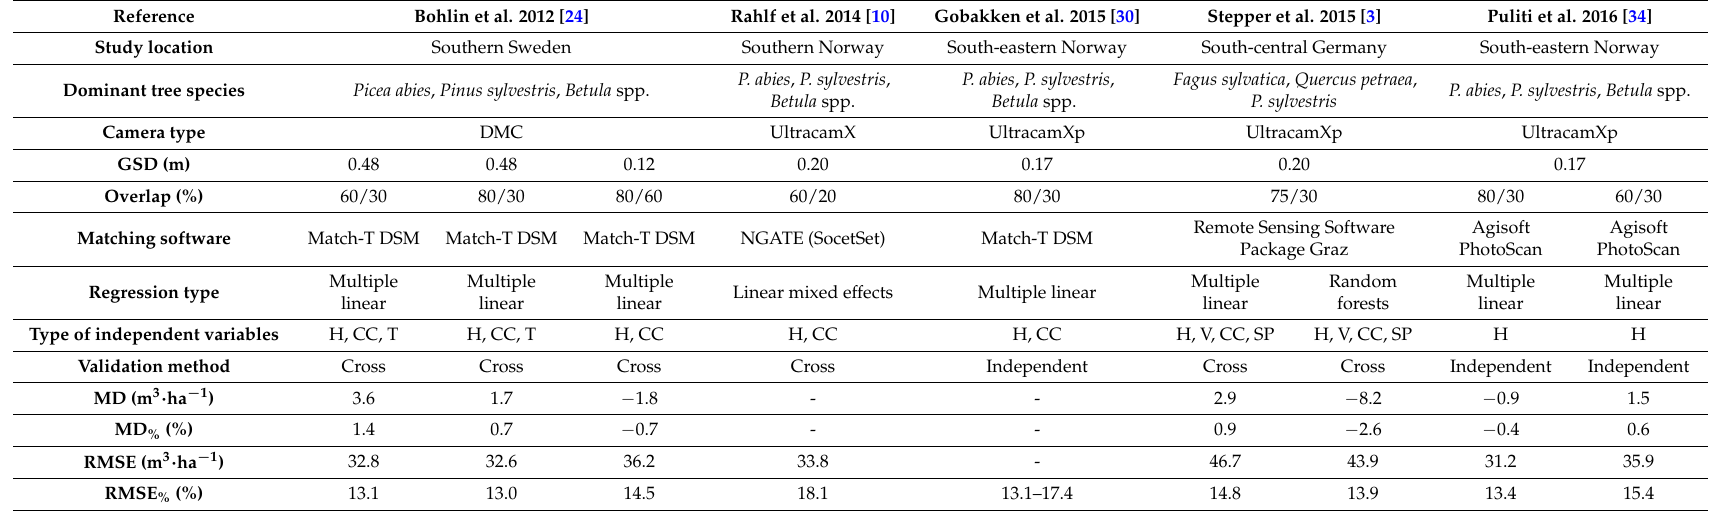
Table 1. Description and results of previous studies dealing with estimation of volume at the stand level using normalized point clouds or canopy height models (CHMs) derived from digital aerial images and airborne laser scanning (ALS) based digital terrain model